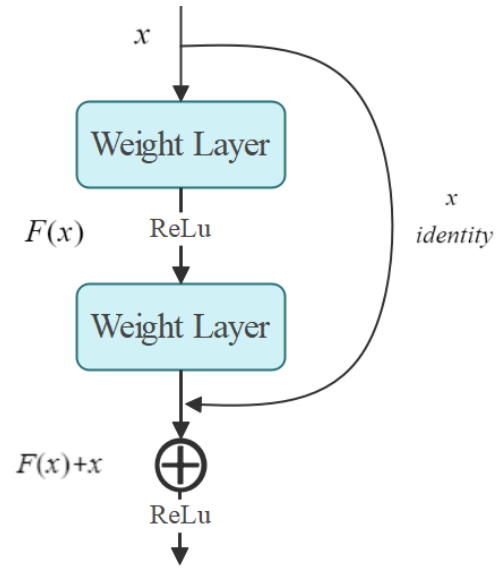
Figure 11. Residual learning module.